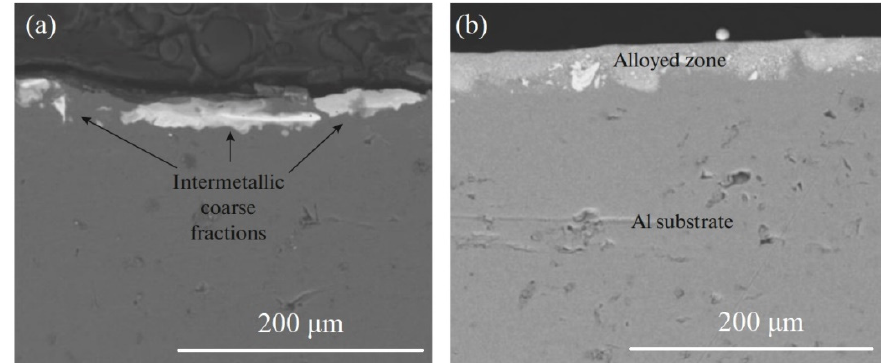
Figure 10. Cross-sectional SEM images of Al–Ti–Nb surface alloys, formed by electron-beam surface alloying with ( a ) higher and ( b ) lower speed of specimen motion [57]. (Reproduced with permission from ref. [57]. Copyright (2018), Springer Nature).